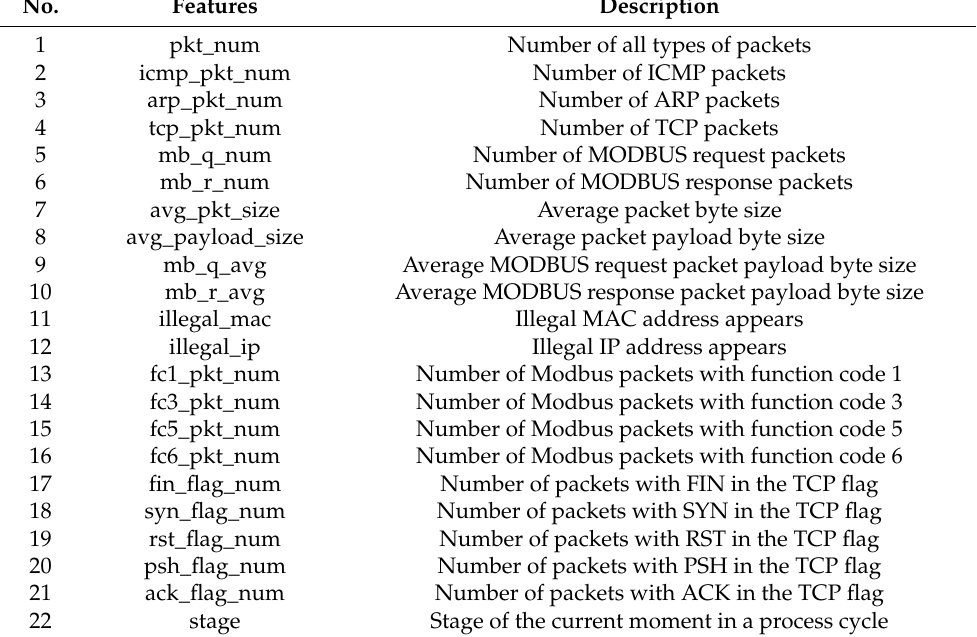
Table 2. Additional extracted